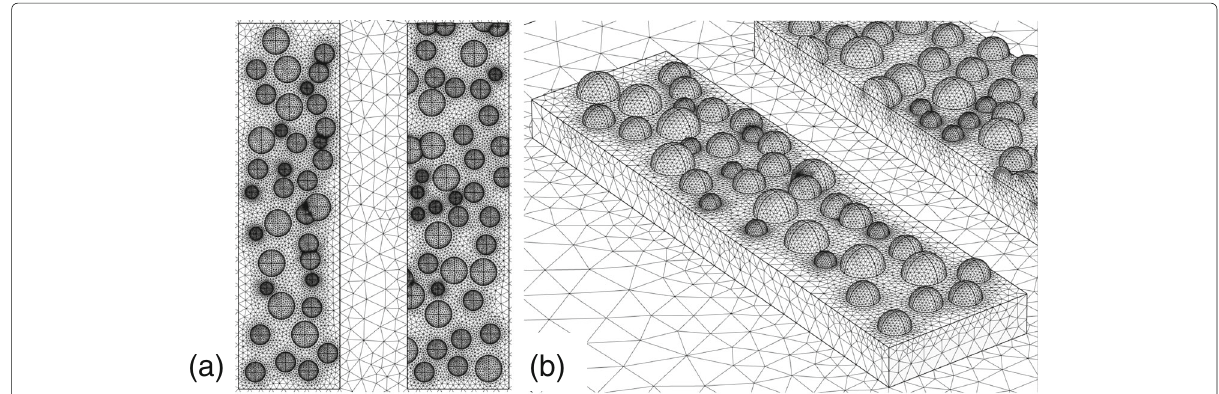
Fig. 10 a The top view and b bird’s eye view of the rough surface modeled using randomly distributed